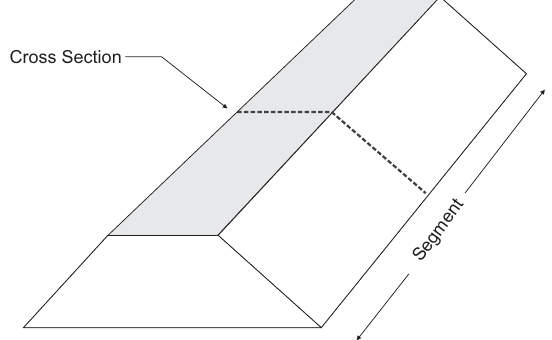
Figure 1. Spatial scales: A levee segment and a cross